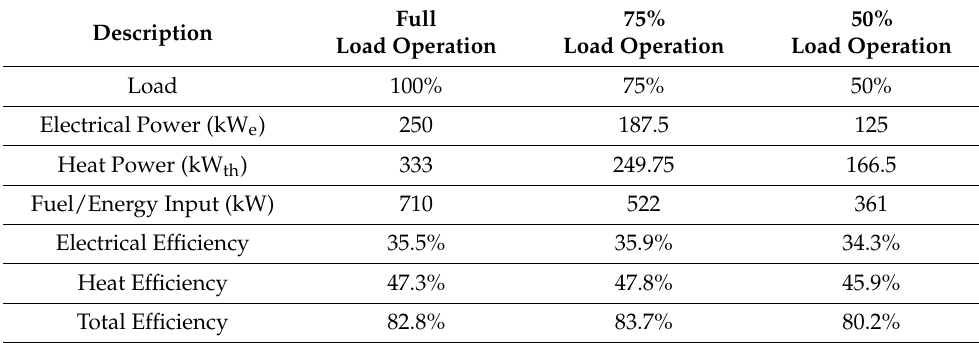
Table 2. CHP Power and Efficiency @ 50 Hz.